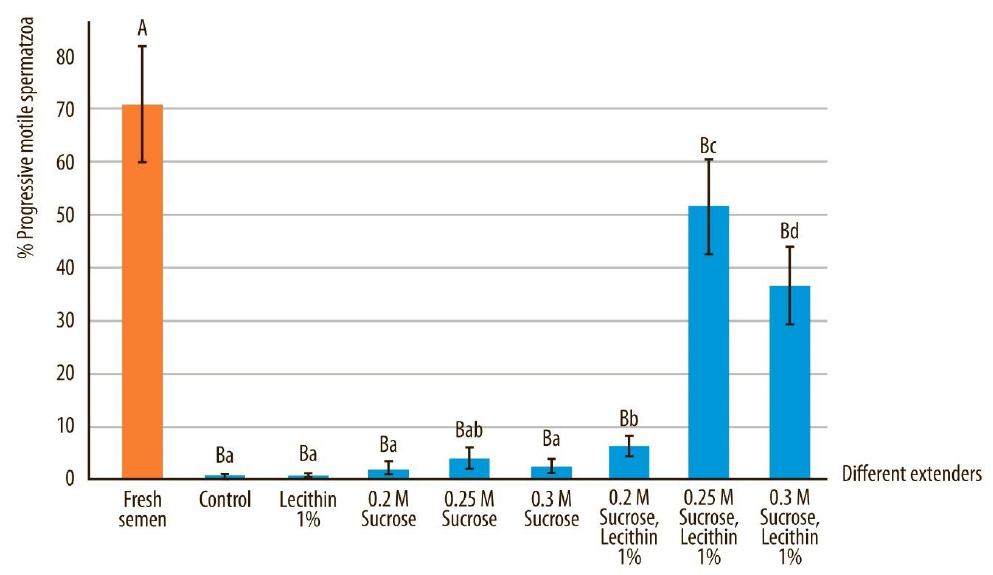
Figure 3. Progressive motility in canine sperm after devitrification regarding different vitrification media. Data are expressed as mean ± SD.